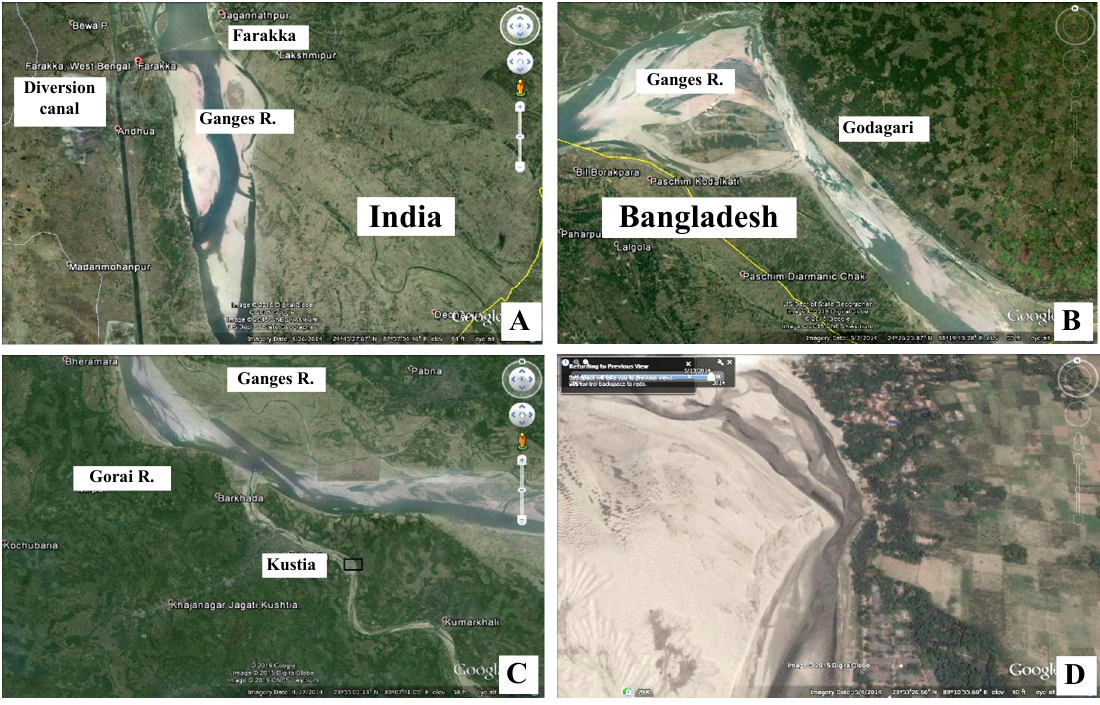
Figure 6. Satellite images of the parts of Ganges River and Gorai River on 15 April 2014. ( A ) Farakka Barrage, diversion canal and immediate downstream (at 24°47 ′ 57.22 ′′ N/87º54 ′ 51.79 ′′ E); ( B ) Heavy sandbars in the Ganges River beside Godagai and Jhinaidaha (at 24°05 ′ 45.31 ′′ N/88°55 ′ 31.04 ′′ E); ( C ) A part of Ganges River and Gorai River (at 23°57 ′ 01.21 ′′ N/89°06 ′ 52.73 ′′ E. The elbow-like part in the rectangle is enlarged in Figure D; ( D ) Huge sandbars, East of Kustia in the Garai River making it almost dry (at 23°53 ′ 27.43 ′′ N/89°10 ′ 16.02 ′′ E). ( A , B ) images from 18 km altitude; ( C ) image from 10 km altitude and ( D ) image from 2 km